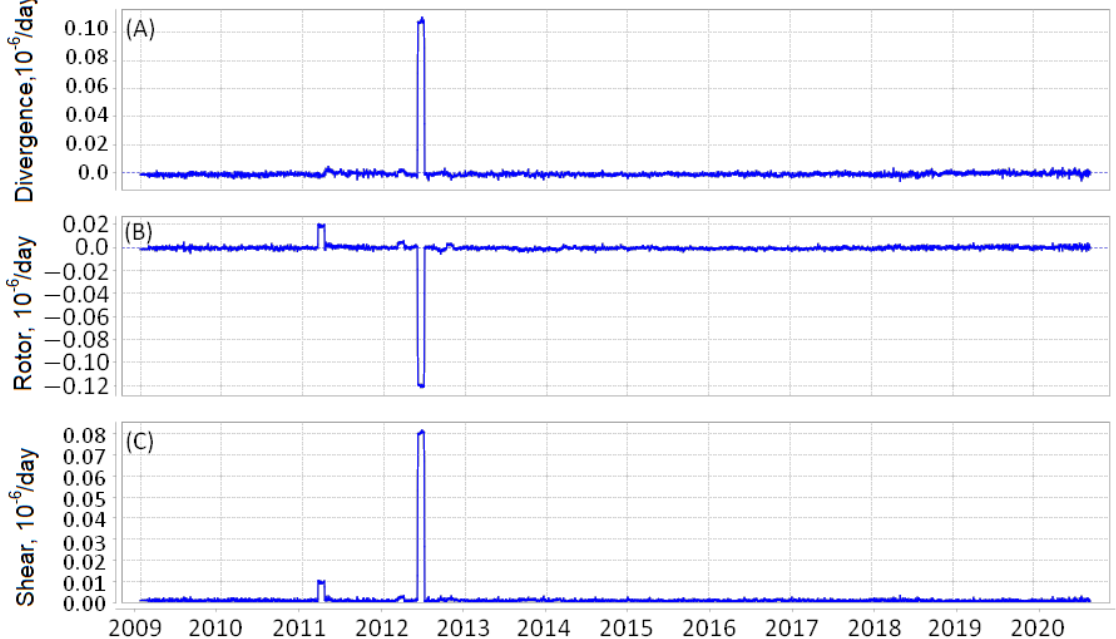
Figure 8. Japan. Time series at point 35.45 ◦ N and 139.2 ◦ E. ( A ) The divergence field F 1 (10 − 6 /day); ( B ) the rotor field F 2 (10 − 6 /day); ( C ) the shear field F 3 (10 − 6